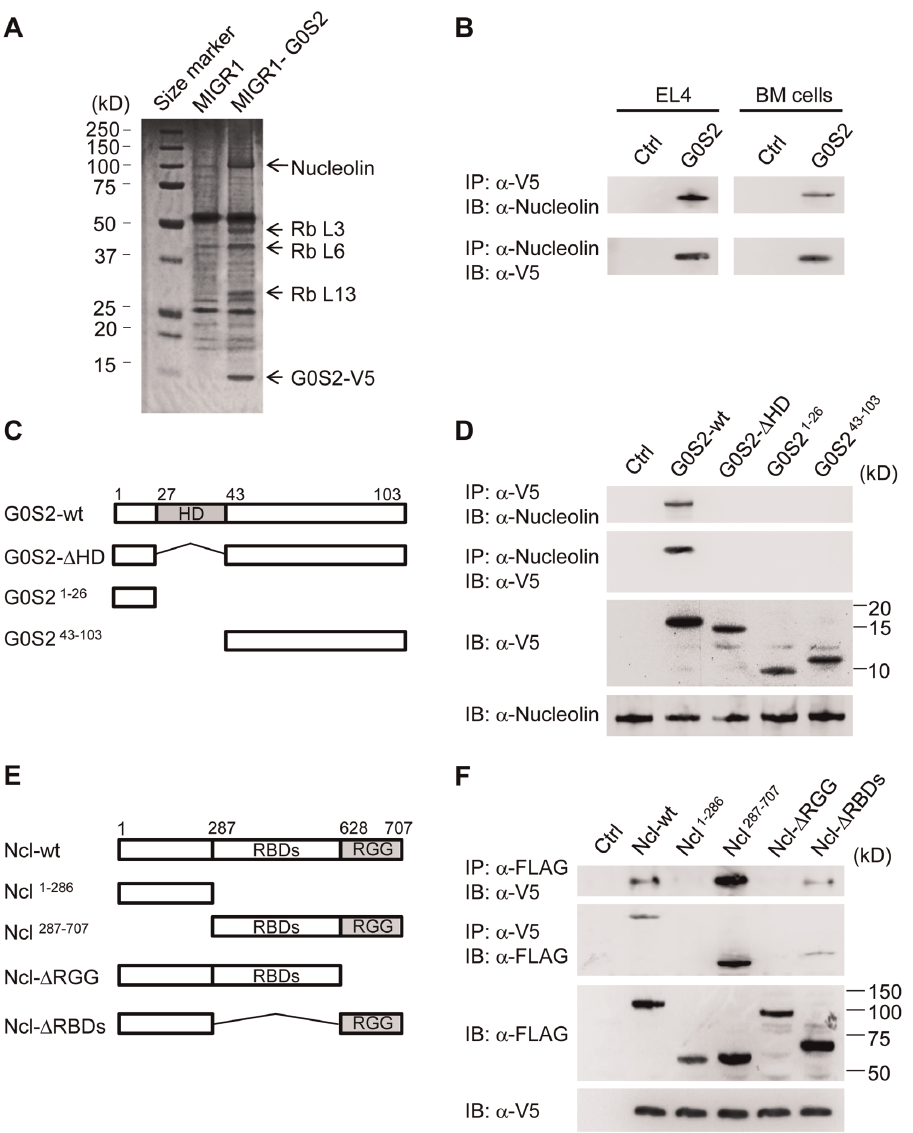
Figure 5. The hydrophobic domain of G0S2 interacts with the RGG domain of nucleolin. Co-immunoprecipitation and proteomic analyses were used to identify G0S2 protein partners. (A) G0S2-interacting proteins were pulled down with anti-V5 antibody in EL4 cells transduced with the empty or G0S2-V5 tagged retrovirus. Bands from a SDS-PAGE gel stained with Coomassie Blue were cut out for identification by mass spectrometry. (B) Reciprocal co-immunoprecipitation of V5-tagged G0S2 and nucleolin in EL4 and BM cells transduced with the MIGR1 (Ctrl) or MIGR1-G0S2 (G0S2) retrovirus. (C) Diagram depicting the domains in the wild-type G0S2 protein and the deletion mutants G0S2- D HD, G0S2 1–26 and G0S2 43–103 . (D) The interaction between endogenous nucleolin and ectopic V5-tagged G0S2 was analyzed in NIH3T3 cells transduced with the empty retrovirus (Ctrl) or retroviruses bearing wild-type G0S2 (G0S2-wt) or G0S2 mutant constructs (G0S2- D HD, G0S2 1–26 and G0S2 43–103 ). (E) Diagram depicting the domains of the wild-type nucleolin (Ncl) protein and the deletion mutants Ncl 1–286 , Ncl 287–707 , Ncl- D RGG and Ncl- D RBDs (FLAG-tagged). RGG, arginine-glycine- glycine-rich domain; RBD, RNA-binding domain. (F) Interactions between V5-tagged G0S2 and FLAG-tagged nucleolin constructs (Ncl-wt, Ncl 1–286 , Ncl 287–707 , Ncl- D RGG and Ncl- D RBDs). The data represent two independent